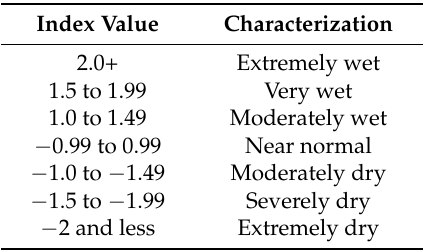
Table 2. Standardized drought index categorization